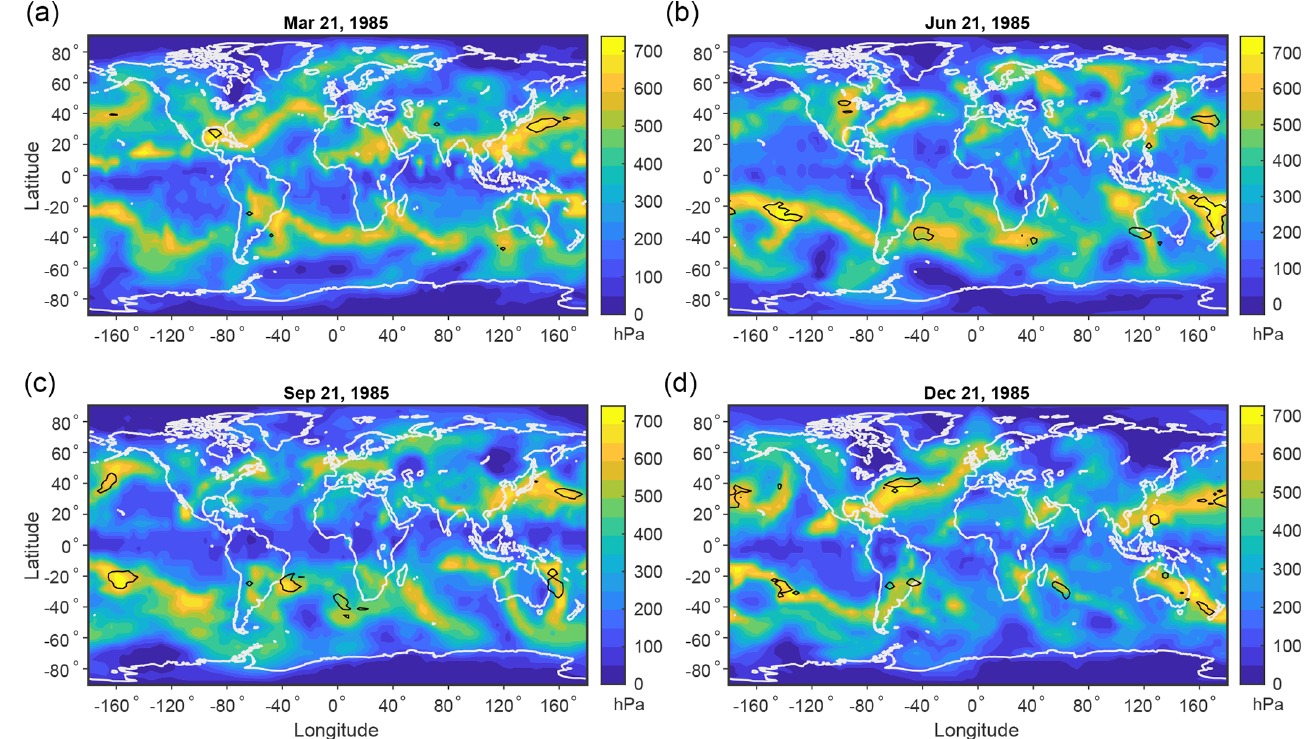
Figure 8. Maximum potential ascent in the local nonconvective MAPE (color shading) and WCB starting points (black contours) for example days in the year 1985. The black contours surround areas of at least one WCB starting point on the given day in the dataset of Madonna et al. (2014).